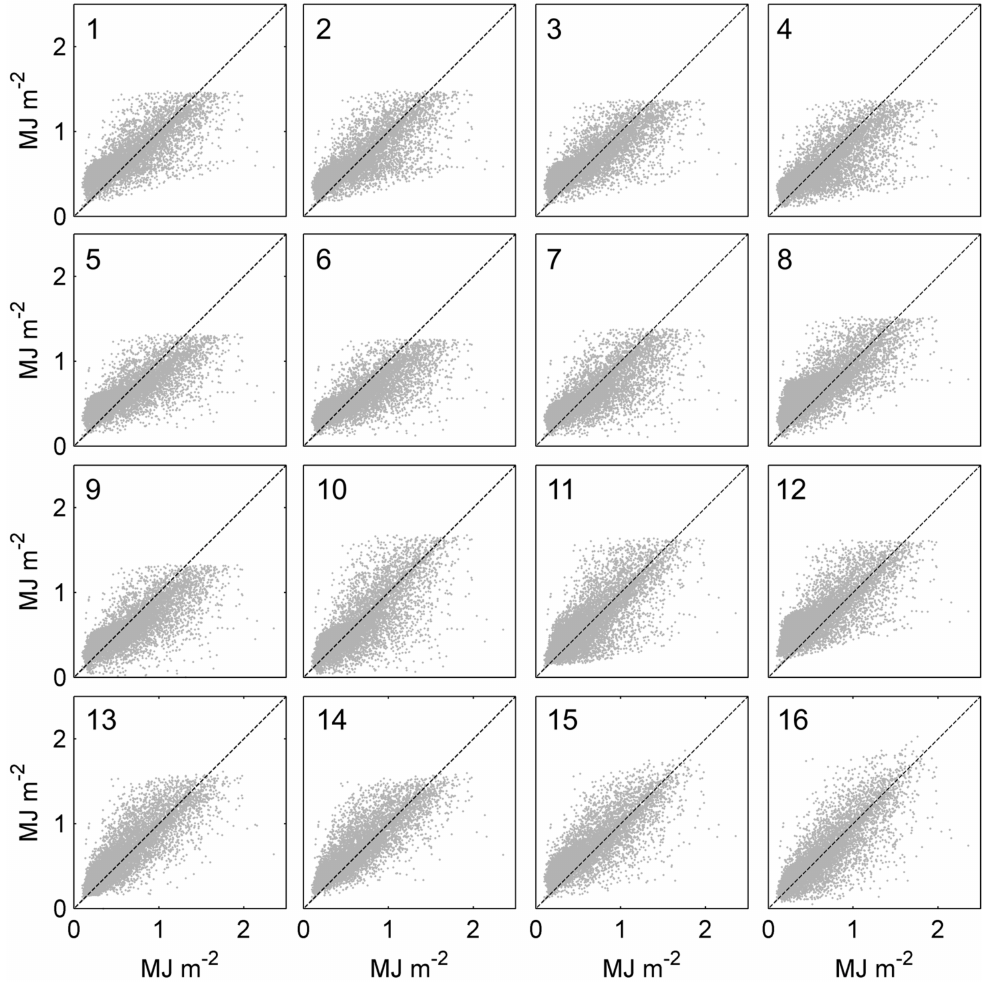
Figure 4. Scatterplots of DHI observations (abscise axis) vs estimates (ordinate axis), according to the compared decomposition models. See Table 1 for the numbers associated with the different models. The black diagonal lines identify the perfect coincidence of observations and